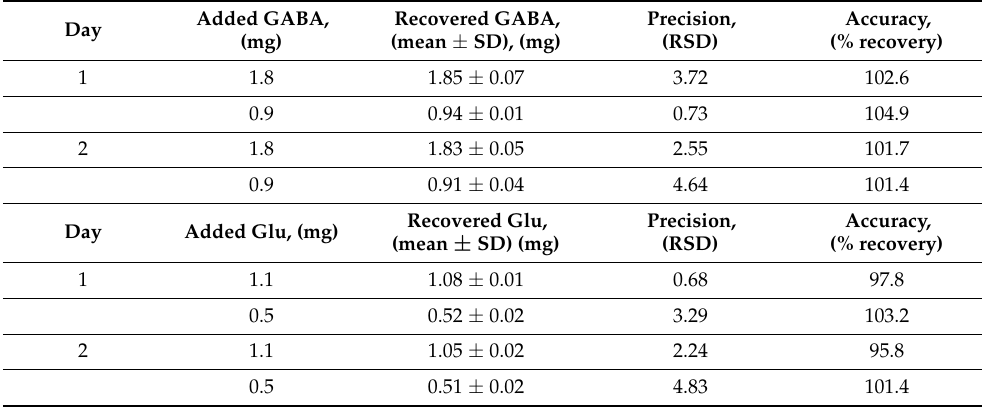
Table 4. Precision (intra-day and inter-day) of HPLC analysis of GABA and Glu ( n =